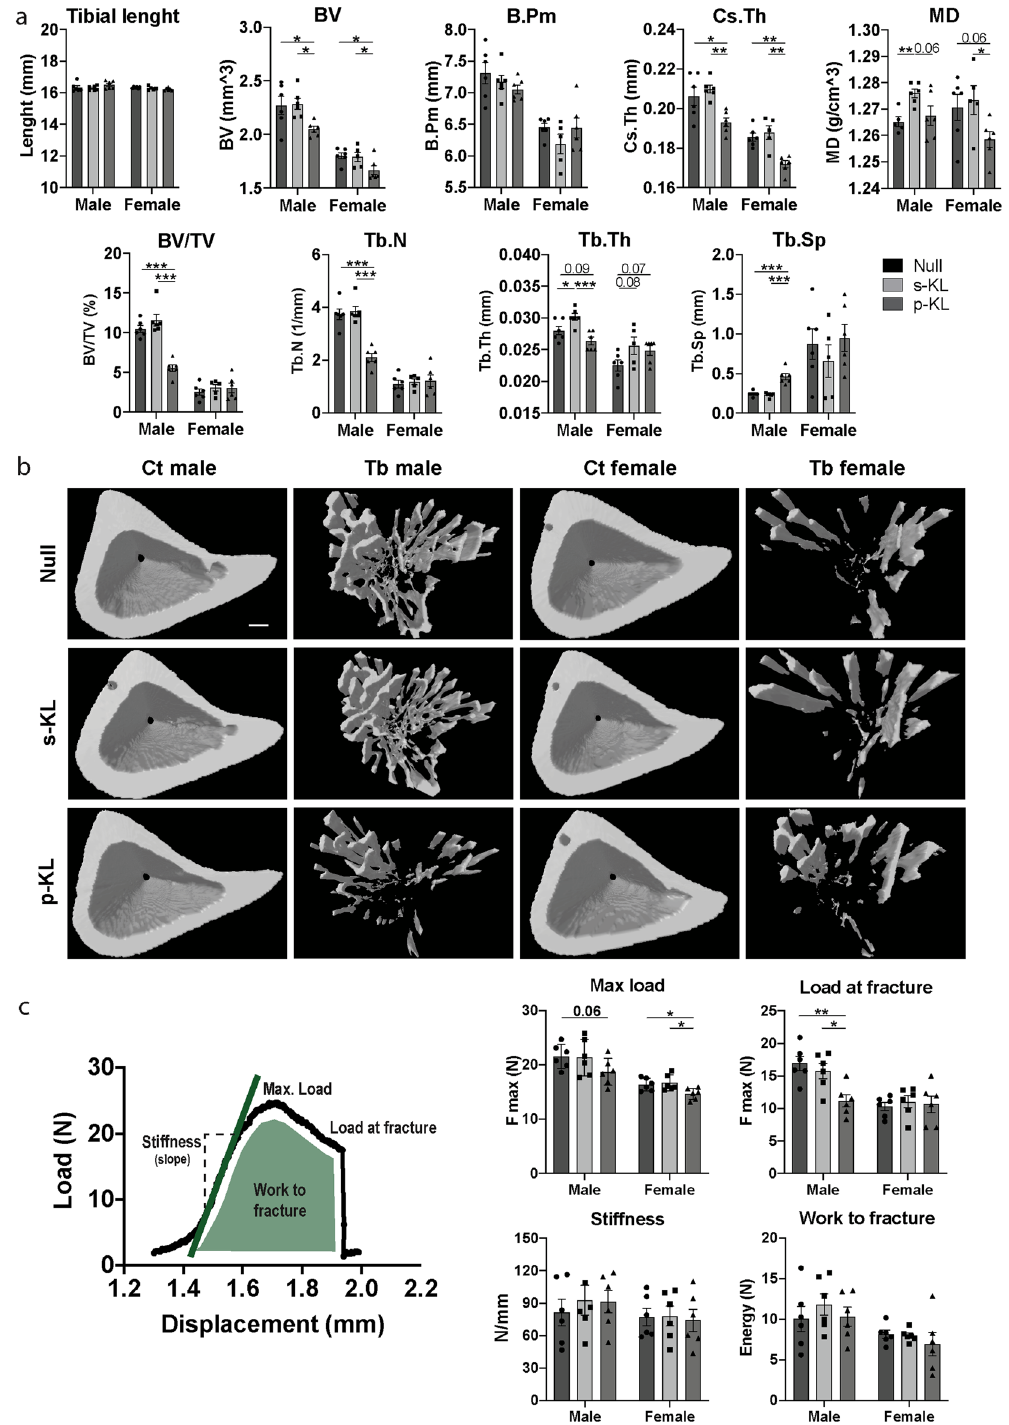
Figure 4. ( a ) MicroCT analysis of different structural variables. Tibial length, BV (bone volume), B.Pm (bone perimeter), CsTh (cross-sectional thickness), Mineral Density (MD), BV/TV (bone volume/tissue volume), Tb.N (trabecular number), Tb.Th (trabecular thickness), Tb.Sp (trabecular space). ( b ) 3D reconstruction of the analyzed ROI. First and third columns corresponding to cortical bone and second and fourth to trabecular bone. Scale bar = 0.2 mm. ( c ) Results of three-point bending test. Data represented as maximum load resisted by the bones, force at fracture, stiffness, and total energy absorbed by the bones during the experiment. Data are presented as fold change expression versus Null treated animals. Mean ± Standard error of the mean (SEM), n = 4–6; *p < 0.05; **p < 0.01; ***p < 0.001; ****p < 0.001 for differences between the treatment